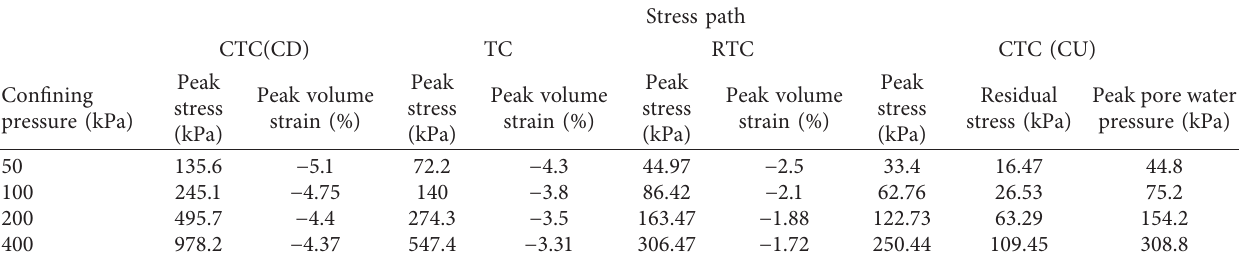
Figure 7: The test results of gravelly sand in p - q space. Deviatoric stress-mean principal stress (a) σ σ 3 � 200kPa; (d) σ 3 � 400kPa. Table 4: Characteristic values of gravelly sand under different stress